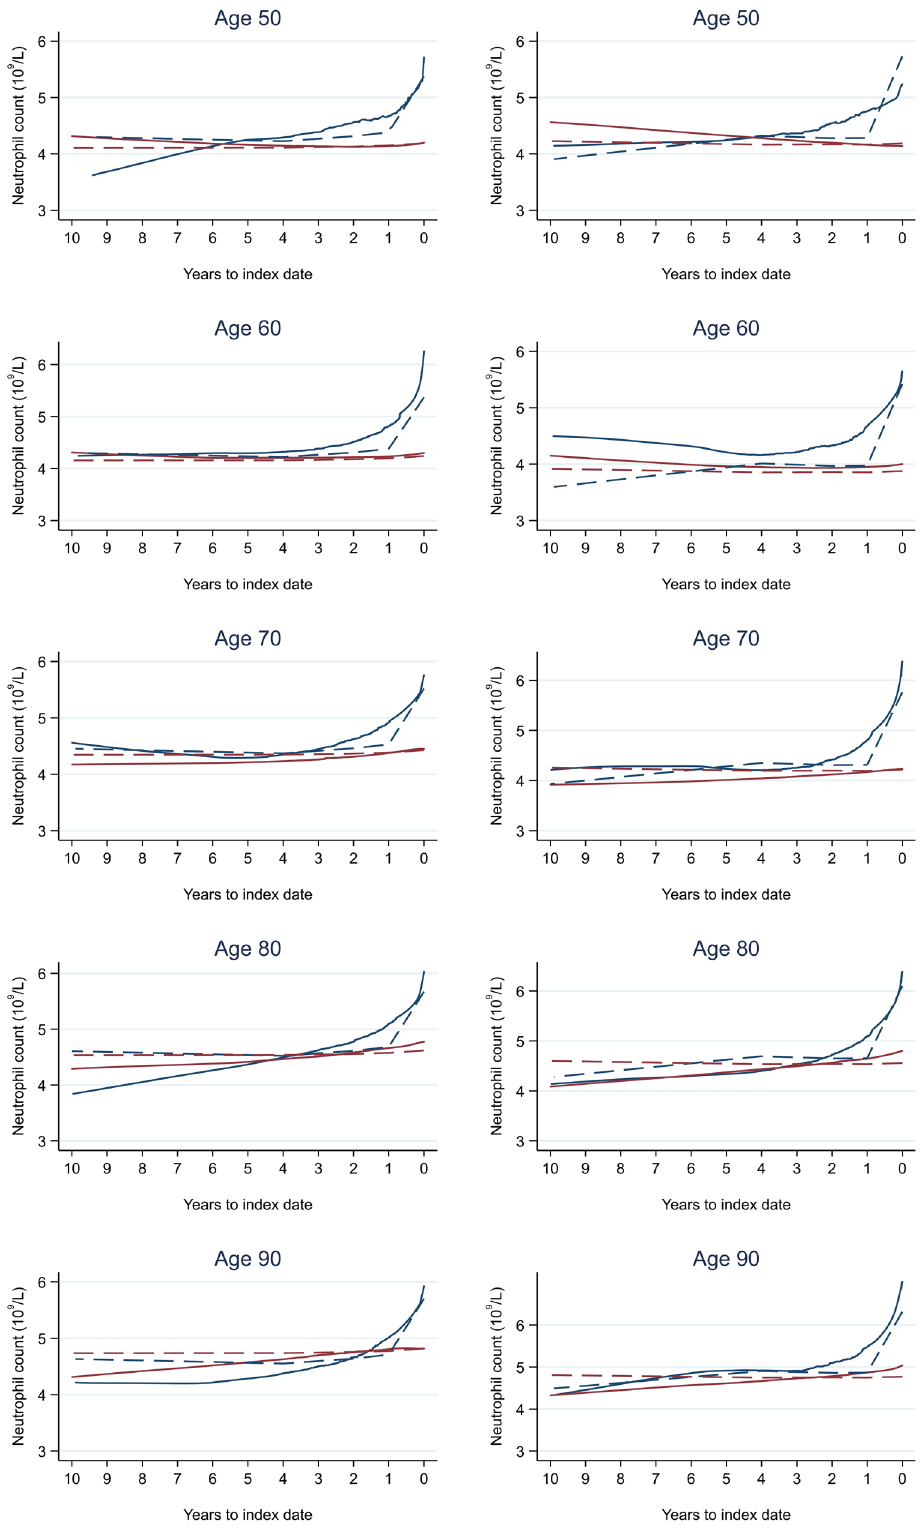
Figure 17. Neutrophil count trends between cases and controls, by age at index date 1,2 . 1 Index date was the date of diagnosis for cases and a randomly selected date in the patient’s study period for controls. 2 LOWESS trends are age (+/- 3 years) and modelled (fixed effects) trends are taken at that specific age. Legend: males (left) and females (right). Colorectal cancer (blue line) and no cancer (red line). LOWESS trend (solid line) and modelled trend (dashed line).